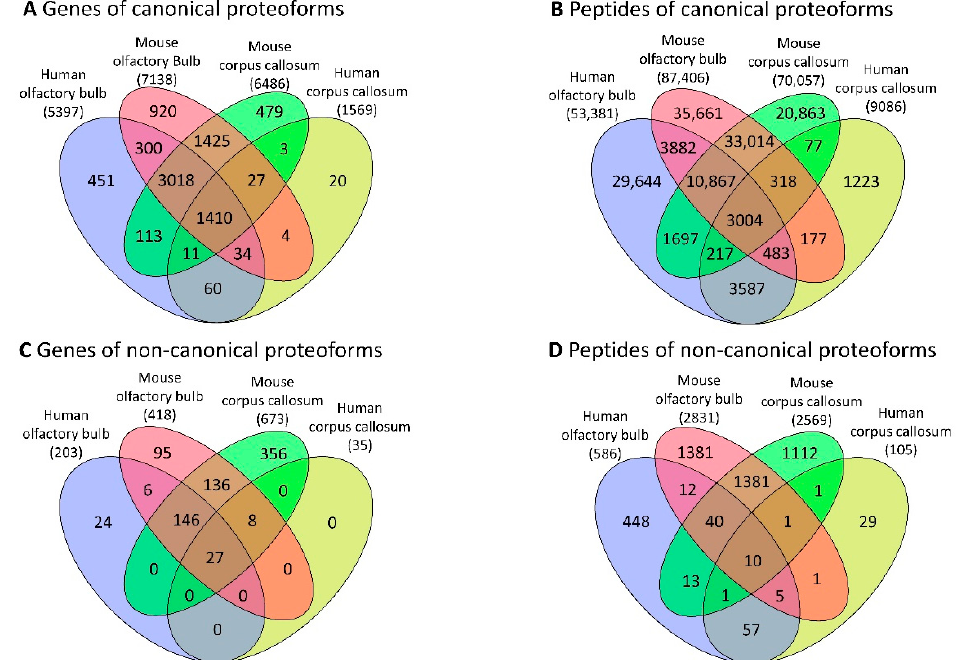
Figure 2. Distribution of genes and peptides across the corpus callosum and olfactory bulb in humans and mice. ( A ) Genes of canonical proteoforms with orthologous relationships between humans and mice or those shared across brain tissues are represented at intersections; ( B ) genes of noncanonical proteoforms with orthologous relationships between humans and mice or those shared across brain tissues are represented at intersections; ( C ) peptides of canonical proteoforms with identical sequences across human and mouse and brain regions are represented at intersections; ( D ) peptides of noncanonical proteoforms with identical sequences across human and mouse and brain tissues are represented at intersections.